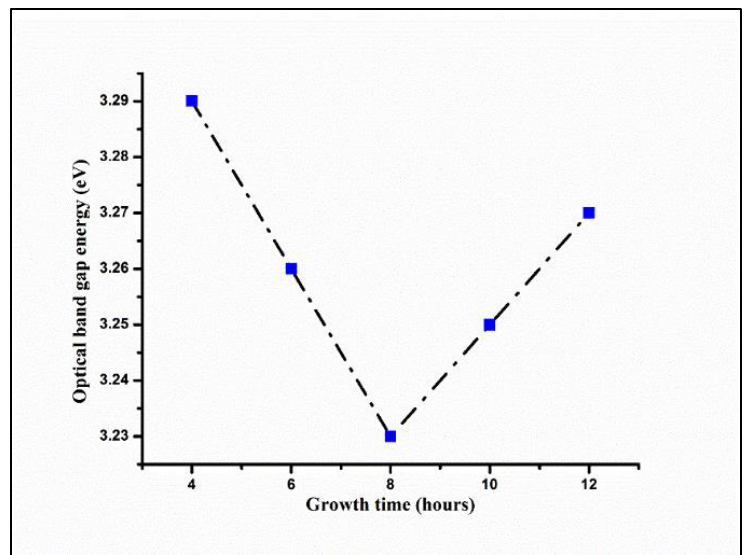
Figure 9. Hydrothermal growth times-dependent variation in the E g values of ZNRAs.